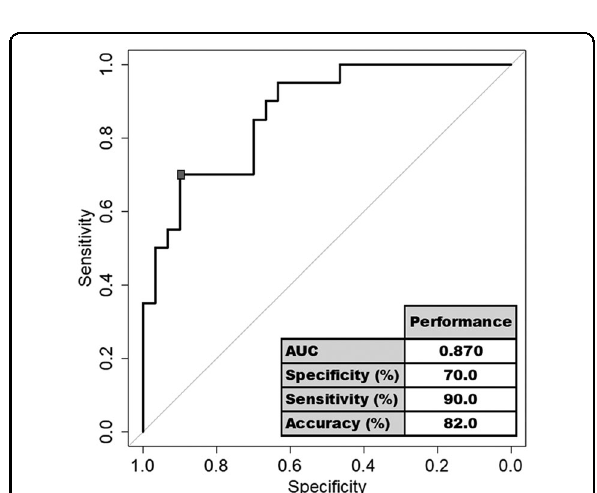
Fig. 5 Diagnostic performances of a combination of PDE8A isoforms which separates suicide attempters from controls. ROC curve of a combination of PDE8A sites and isoforms, which separate the population of suicide attempters ( n = 76) from healthy controls ( n = 99). Diagnostic performances of the algorithm are indicated on the